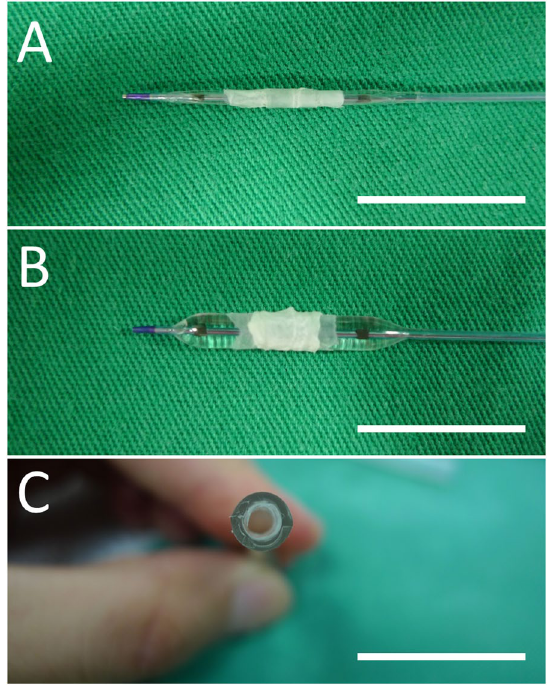
Figure 2. The biodegradable stents ( A ) before and ( B ) after expansion by a balloon ( C ) expansion on plastic tube (Scale bar = 15